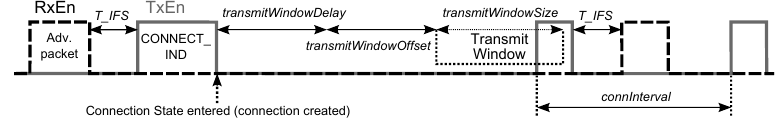
Figure 6. Transmit Window. After receiving the advertising packet form the slave, master sends the CONNECT_IND packet to the slave and transitions to the Connection State. The start of the first data packet, which determines the anchor point for the first connection event, and therefore the timings of all future connection events in this connection, is no earlier than transmitWindowDelay + transmitWindowOf fset and no later than transmitWindowDelay + transmitWindowOf fset + transmitWindowSize after the end of the CONNECT_IND packet ( transmitWindowDelay = 1.25